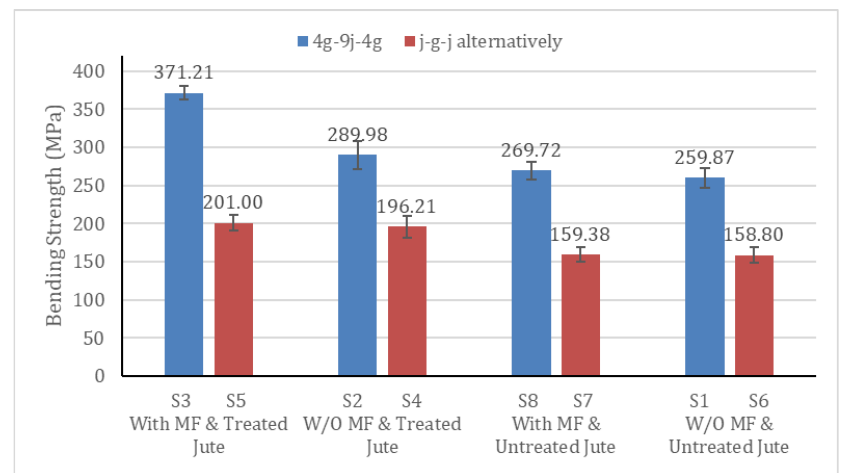
Figure 9: Average bending strength comparisons of fabricated hybrid composite panels.